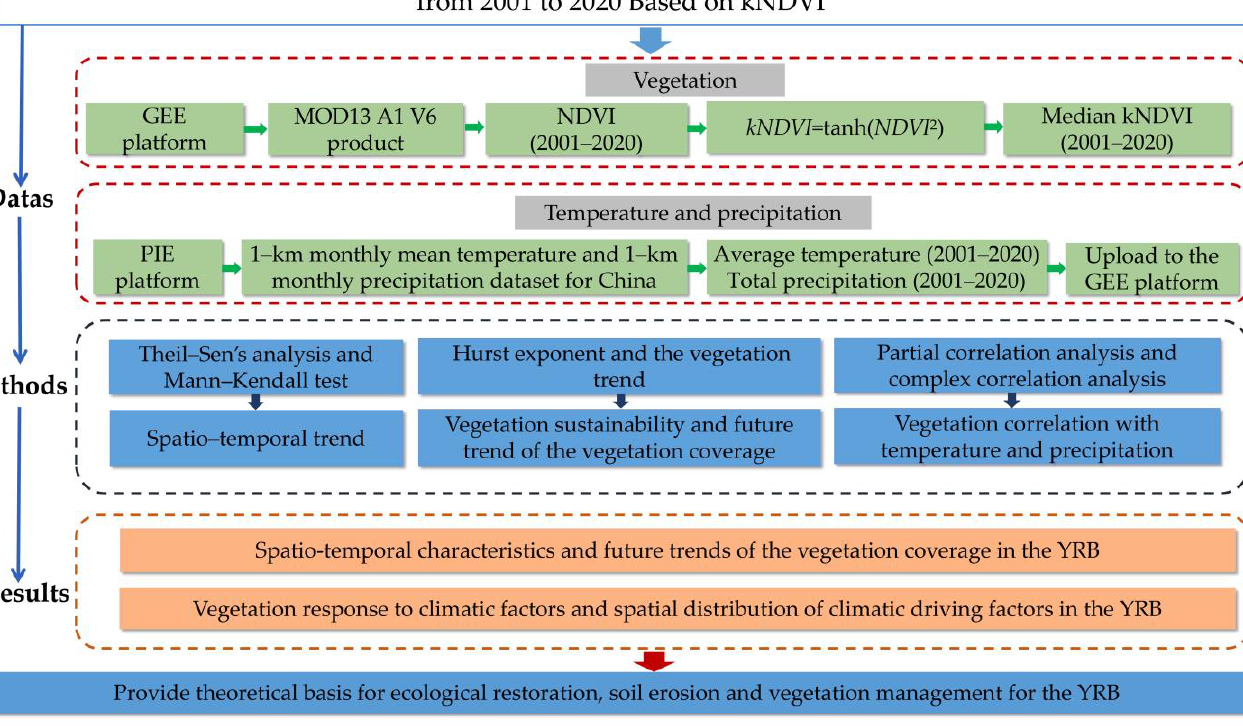
Figure 2. Flow chart of the research.